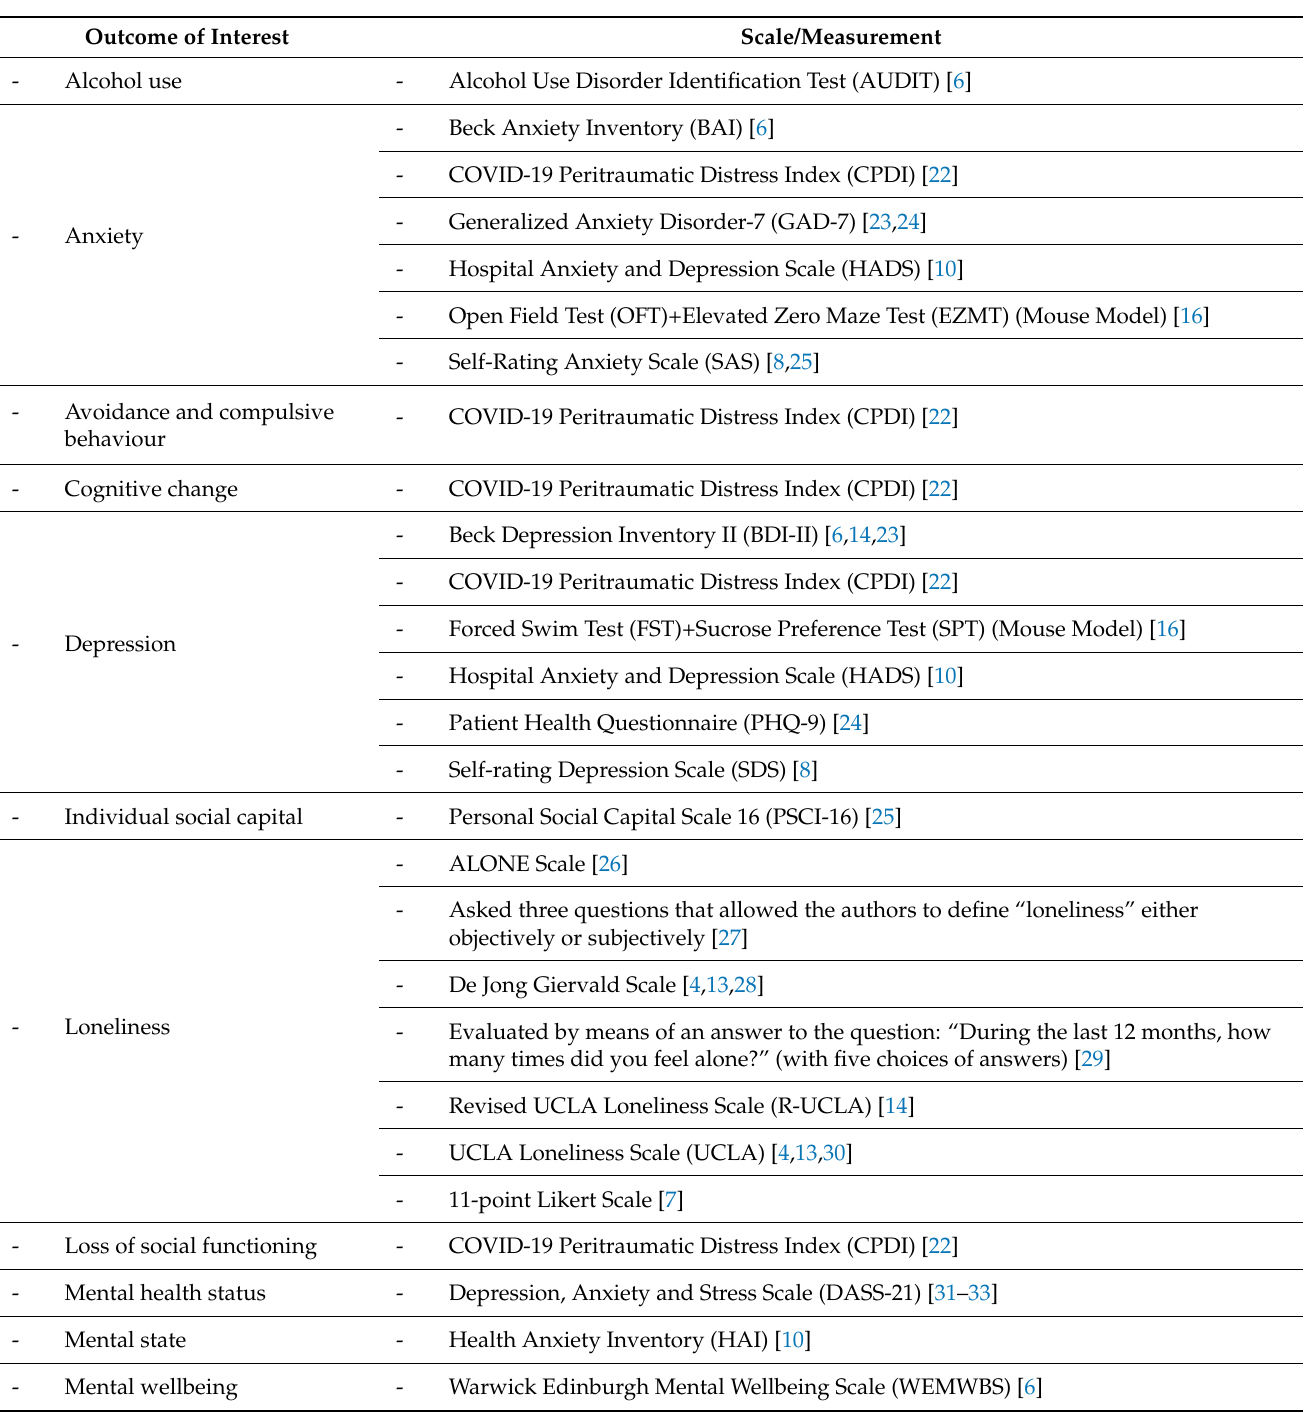
Table 1. The variables mentioned and their respective methods of measurement, from our referenced studies. Outcome of